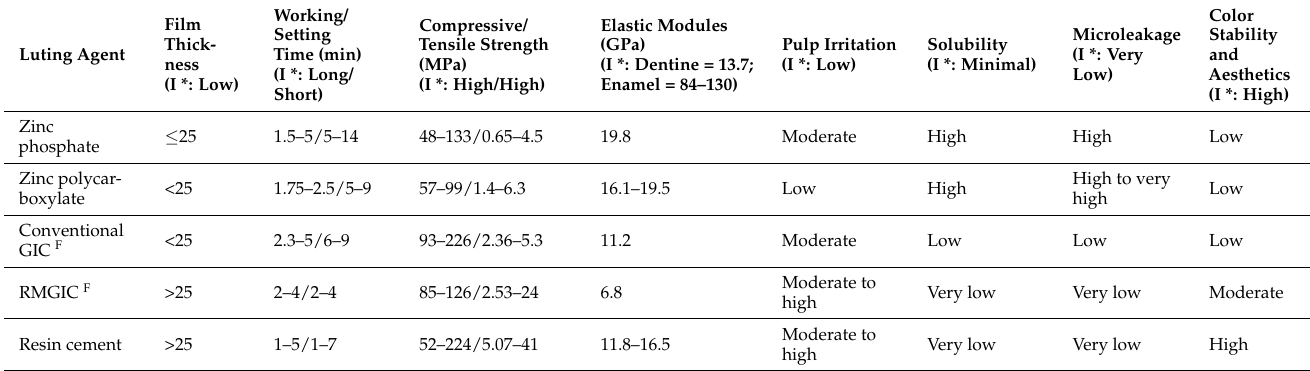
Table 2. Basic properties of various dental luting agents [16,22,27].